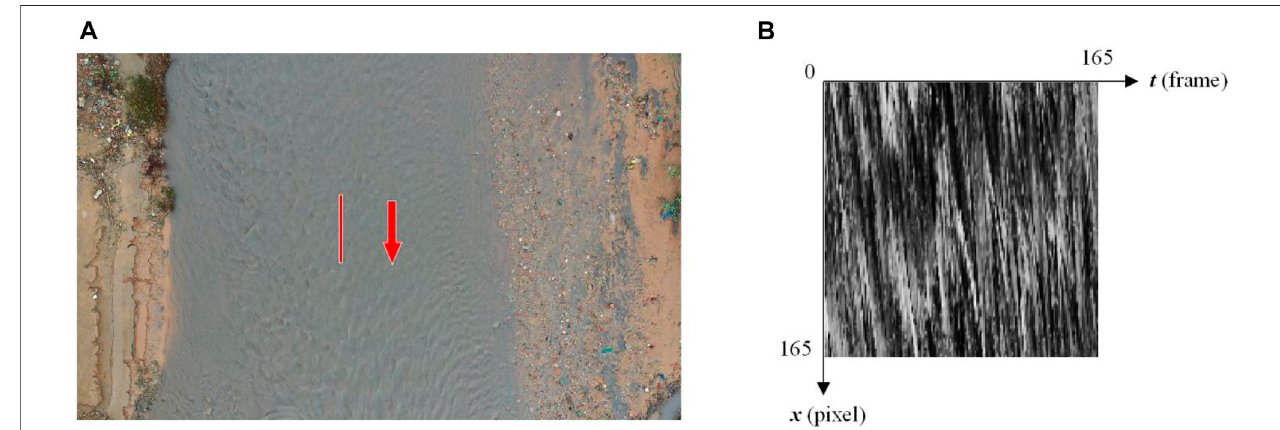
FIGURE 1 | Principle of STIV. (A) A search line set along the direction of the river fl ow. (B) A space-time image generated from the search line.